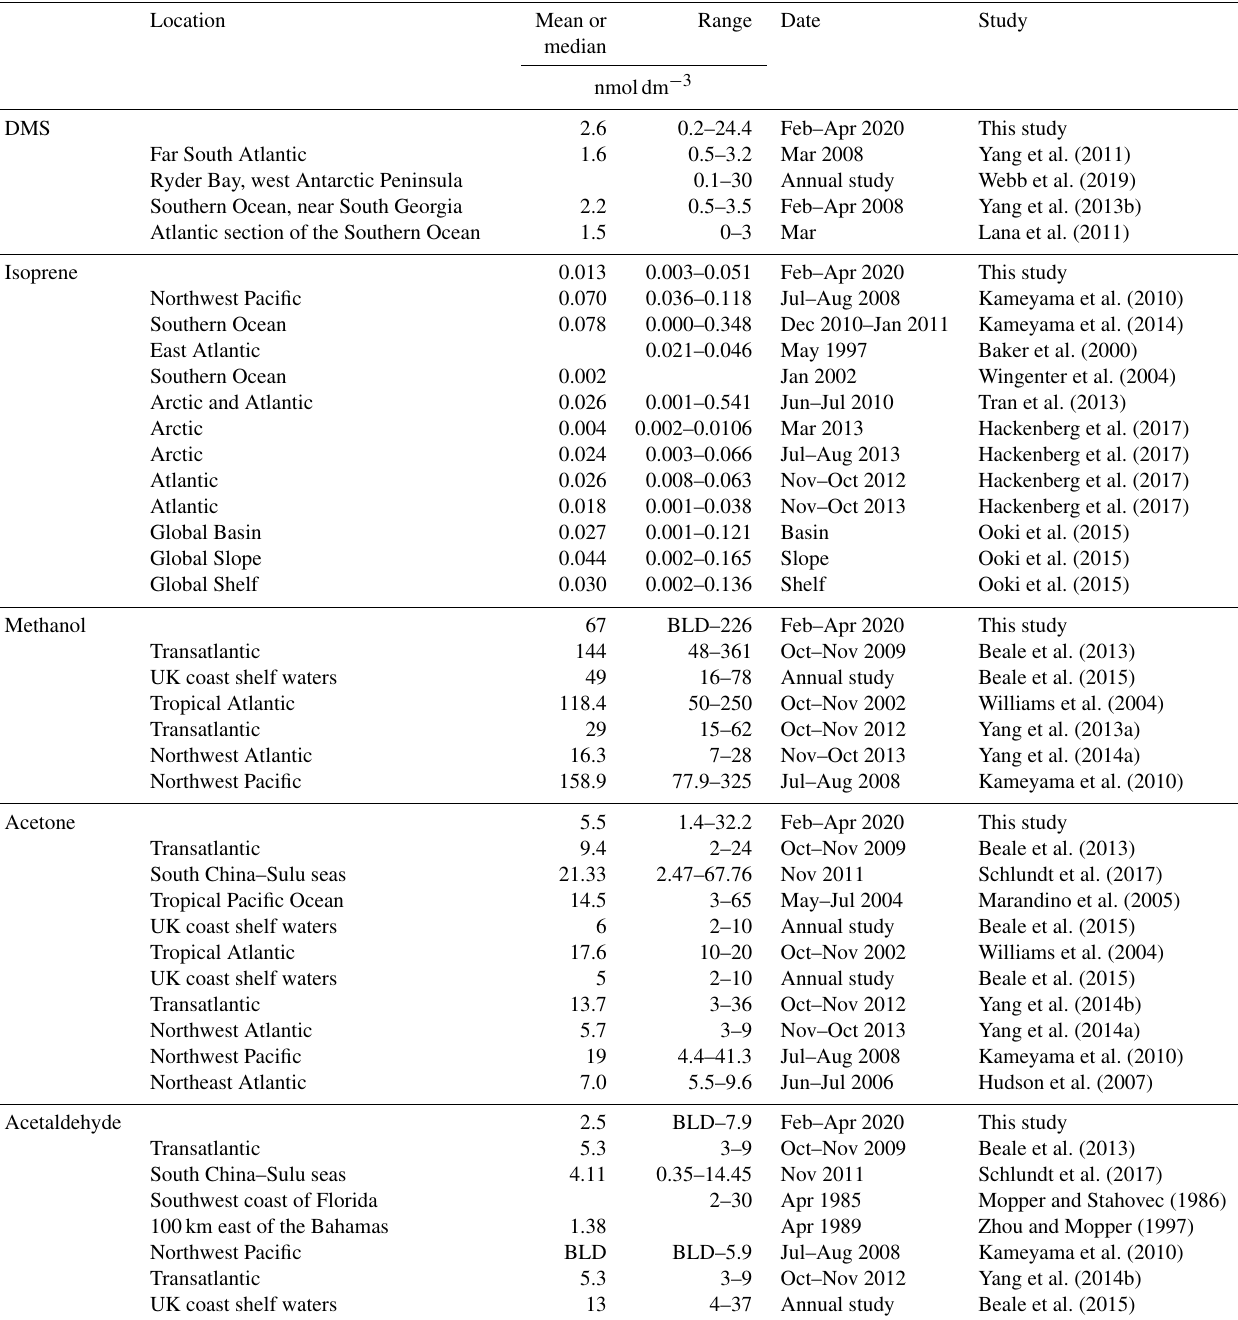
Table 4. Table summarizing previous surface seawater measurements of DMS, isoprene, methanol, acetone, and acetaldehyde in the Southern Ocean and other regions (BLD is below limit of